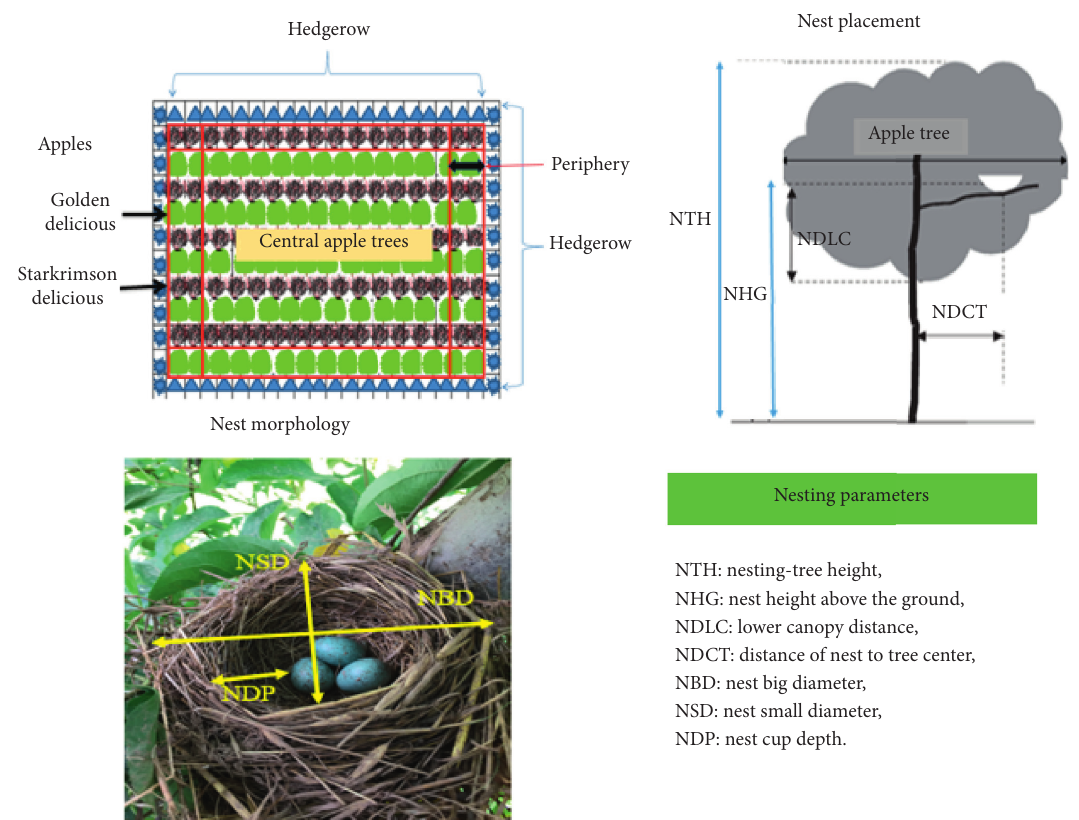
Figure 2: Nesting sites, placement, and morphology of the Blackbird in the Ait Ayach